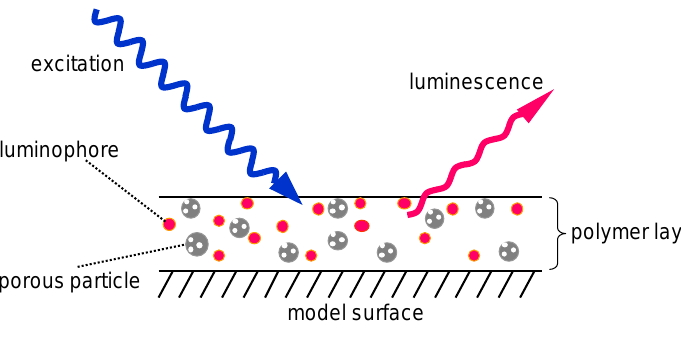
Figure 1. Schematic description of a polymer ceramic PSP (PC-PSP).